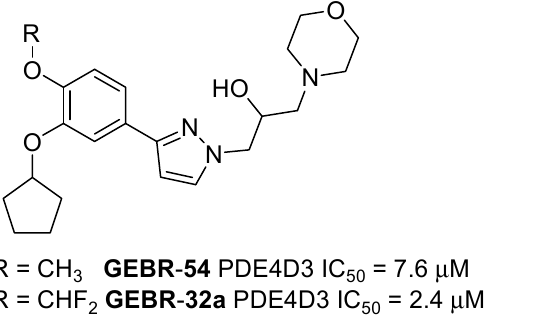
Figure 2. Structures of PDE4D Inhibitors with memory enhancing and anti-inflammatory activities. Corresponding IC 50 values relative to PDE4D3 inhibition are reported.